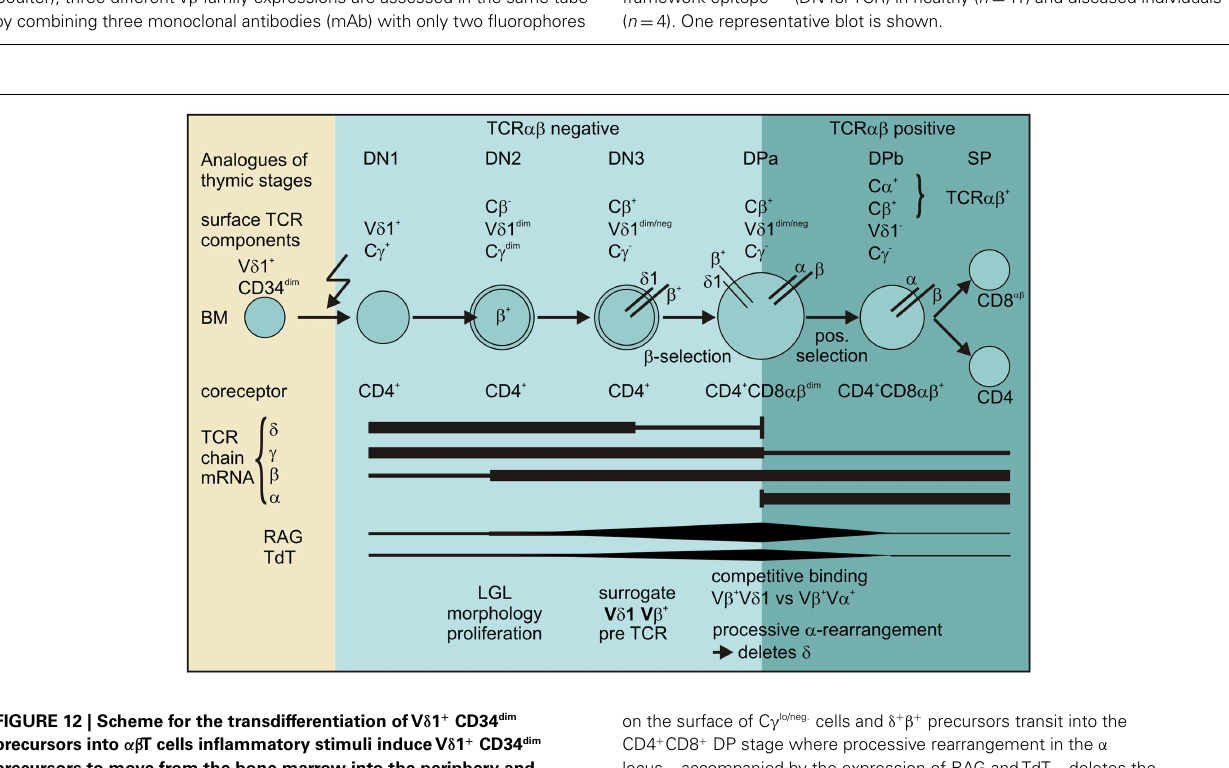
on the surface of C γ lo/neg. cells and δ + β + precursors transit into the CD4 + CD8 + DP stage where processive rearrangement in the α locus – accompanied by the expression of RAG andTdT – deletes the δ -chain, leading to the successive loss ofV δ 1 onV δ 1 dim V β + cells.V β + chains preferentially pair with newly formed α chains inV δ 1 dim/neg. V β + cells that become weakly positive forTCR- αβ before they completely loseV δ 1 expression, upregulateTCR- αβ and become mature and functional SP CD4 + or CD8 + αβ T